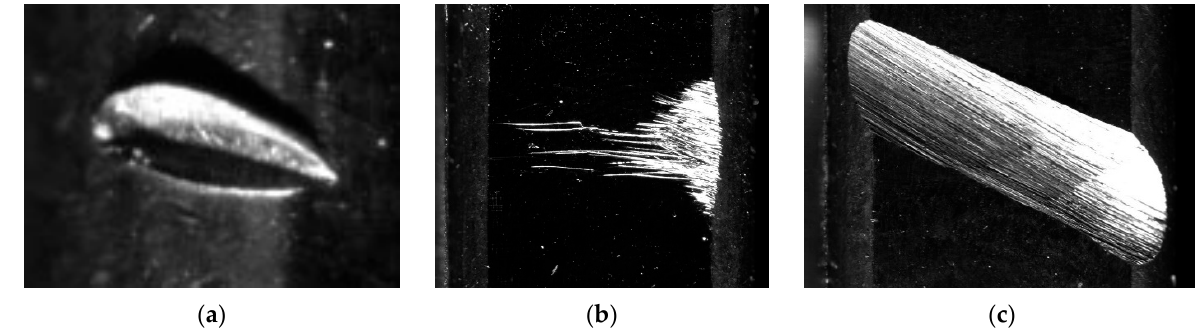
Figure 7. Examples of the defect images: ( a ) original image of the bruise defect; ( b ) original image of the scratch defect; ( c ) original image of over-grinding.